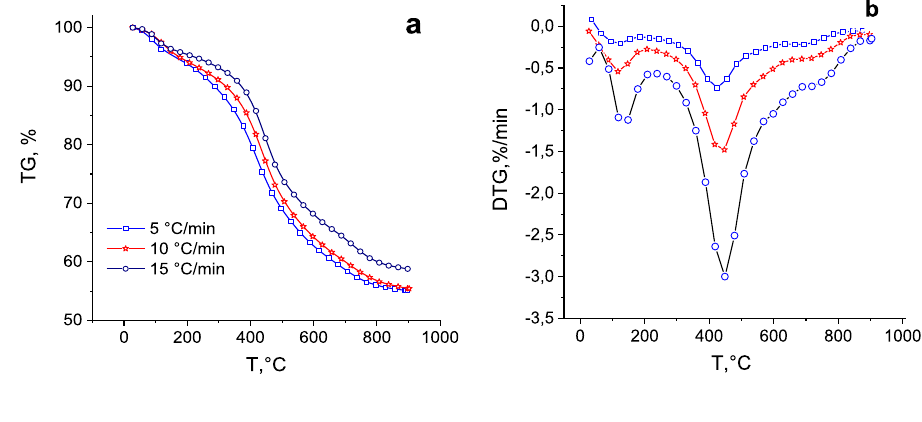
Fig. 6 a TG and b DTG pyroly- sis curves of Baganuur coal at different heating